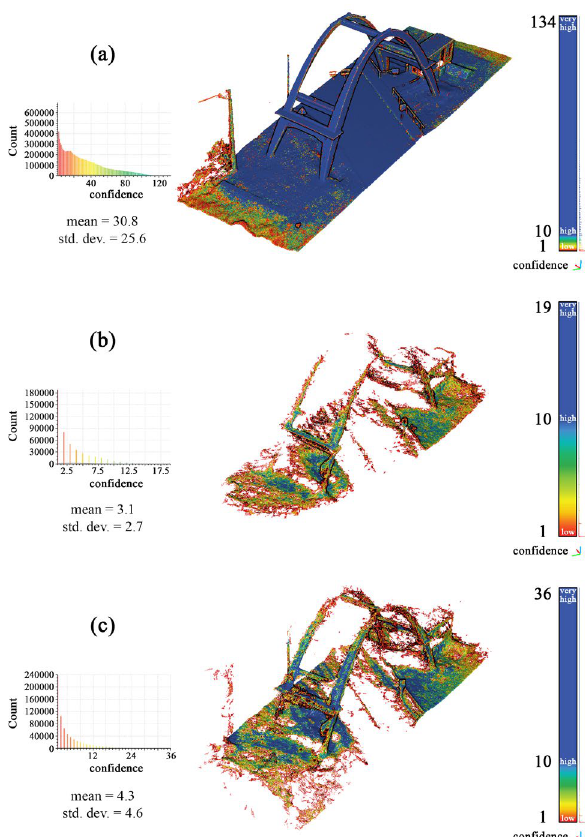
Figure 13 . Parabolic arch of Morano sul Po, point clouds confidence: (a) dense point cloud derived from visible dataset; (b) dense point cloud derived from thermal dataset (Workflow 1); (c) dense point cloud derived from thermal dataset (Workflow 2).